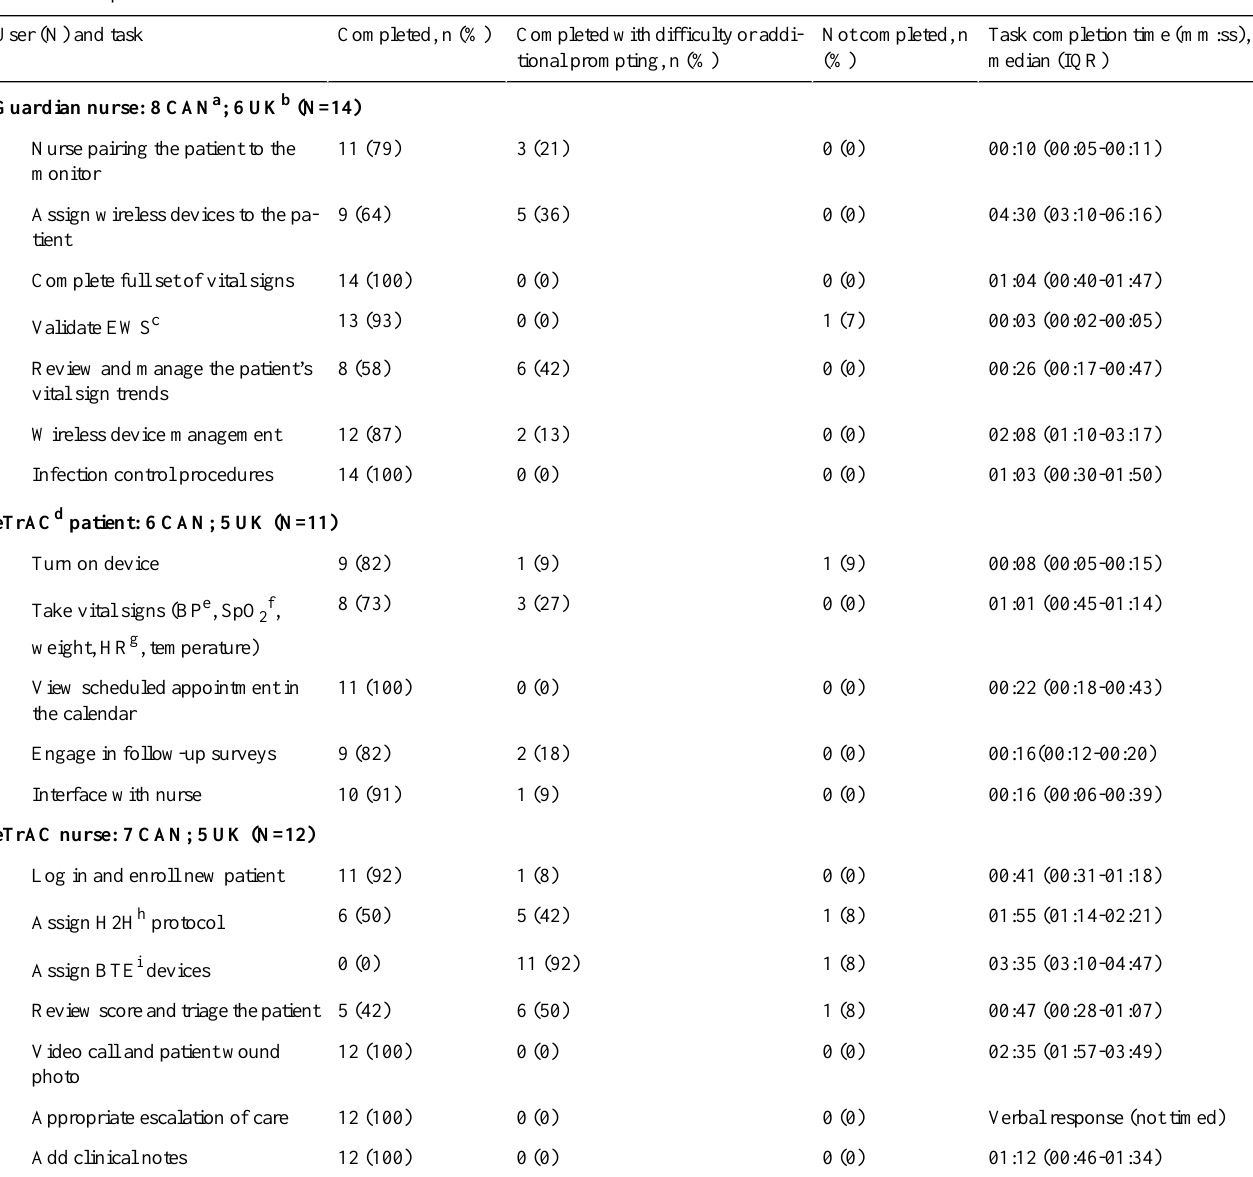
Table 3. User performance.